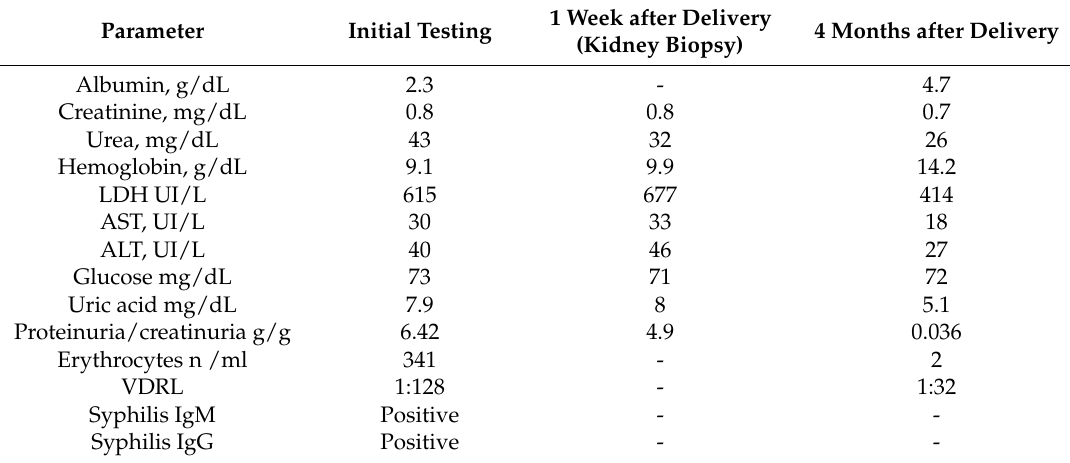
Figure 4. Direct immunofluorescence study with four immunoreactants. IgG and IgM, were negative. IgA showed positivity with a fine granular pattern, specifically in the capillary loops (3+). Mesangial stain is minor. C3c showed granular deposits, especially in the capillary walls (2+). Table 1. Summary of the main biochemical tests.